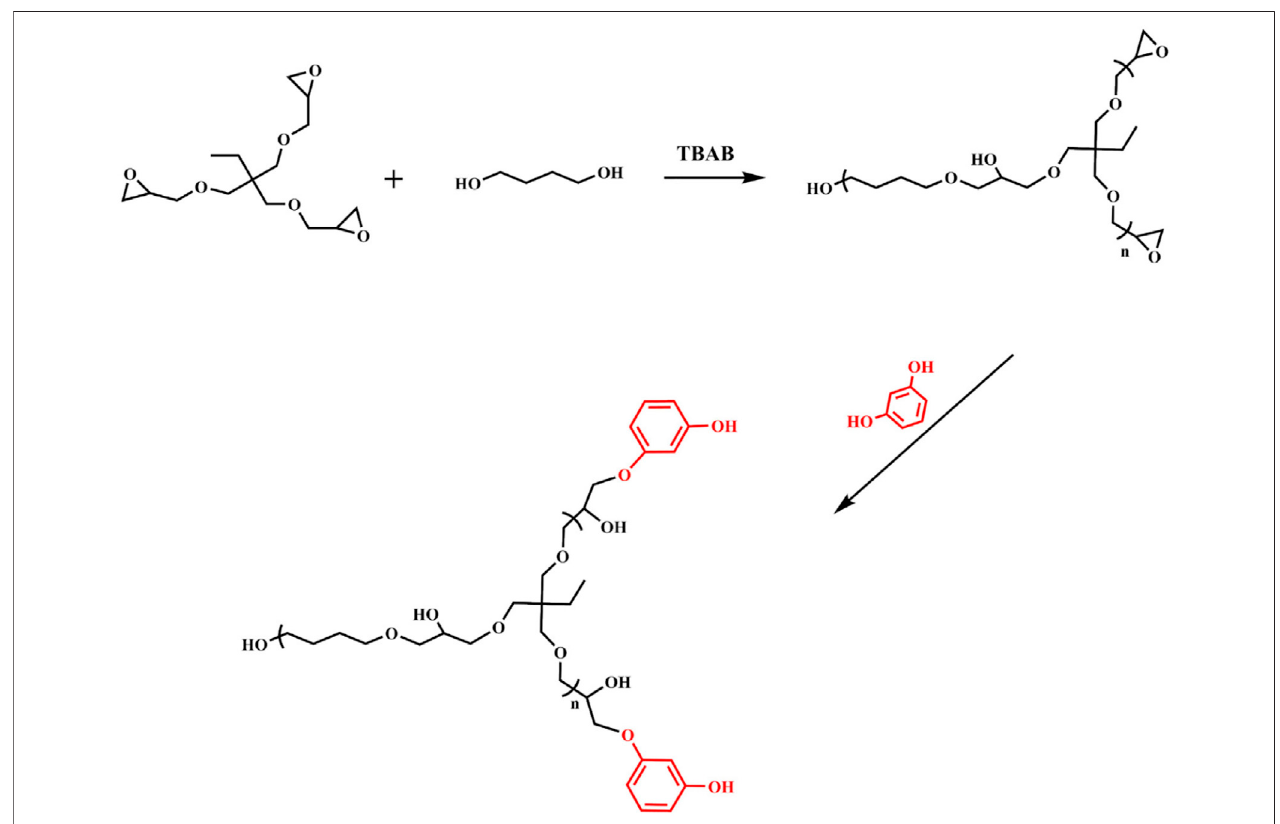
FIGURE 3 | Synthesis route for the hydroxyl-containing hyperbranched polymer (Xing et al., 2020).